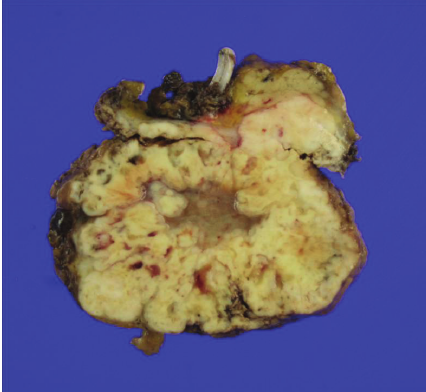
Figure 5: Grossly the adrenal mass is pale yellowish solid with lobular pattern and centrally myxoid degeneration and geographic